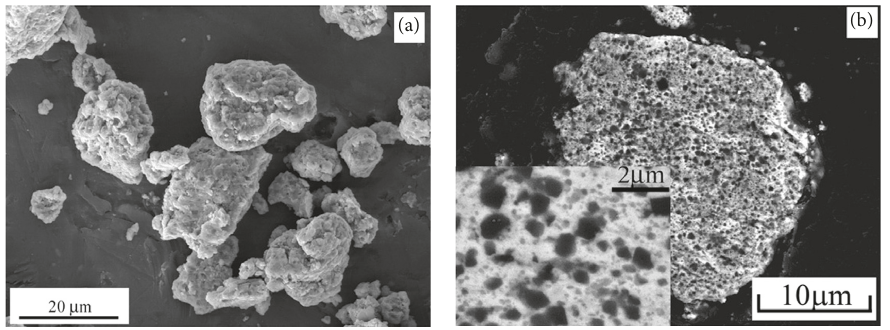
Figure 21: SEM imaging of the cBN-NiCrAl MMC powder after ball milling for 40h: (a) morphology and (b) cross section. The bright regions and dark dots in (b) correspond to NiCrAl alloy and cBN particles.